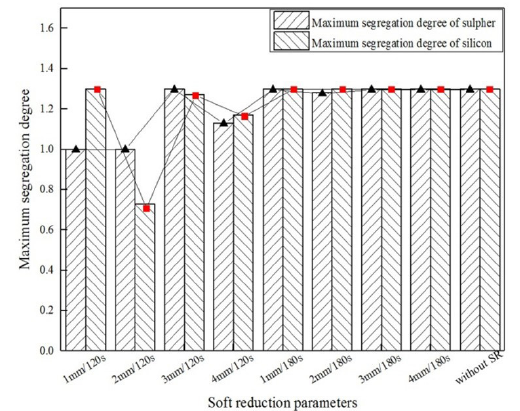
Figure 10. Maximum segregation degree of sulphur and silicon at different soft reduction parameters.